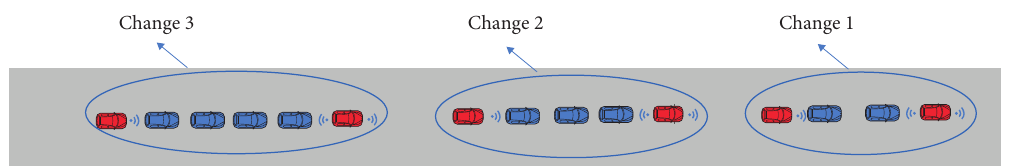
Figure 9: The regular alignment of the fleet.